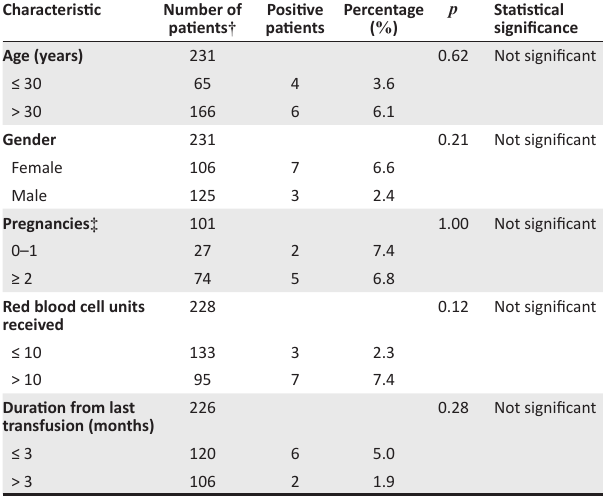
TABLE 4: Factors associated with alloimmunisation in multi-transfused patients with chronic renal failure, Yalgado Ouedraogo Teaching Hospital, Ouagadougou, Burkina Faso,